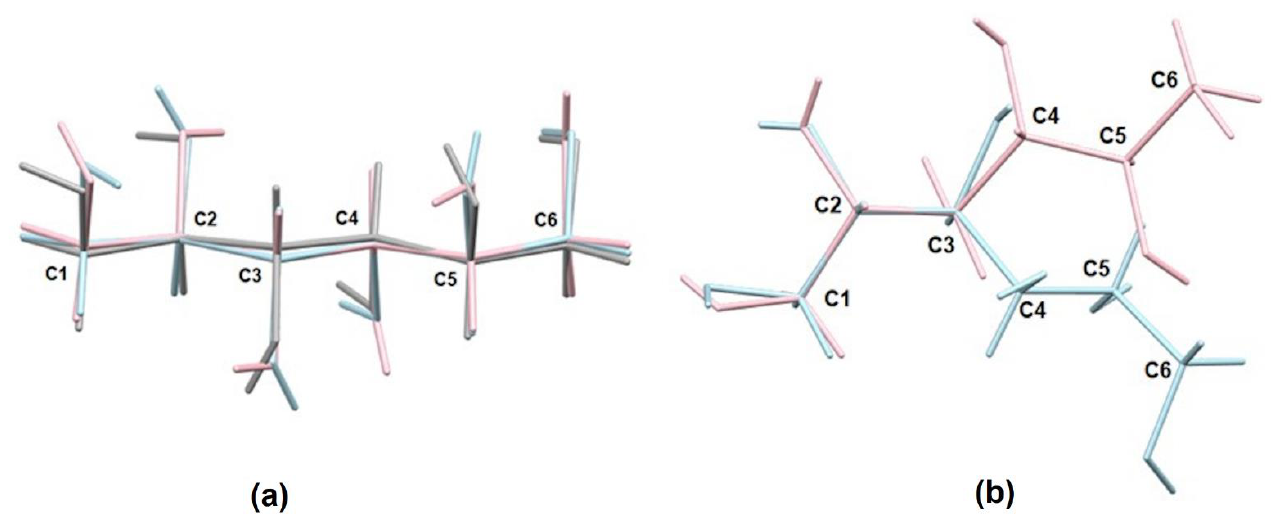
Figure 1. Overlay of rotamers of ( a ) D-mannitol— α (blue), β (pink), and δ (grey) [12]; and ( b ) sorbitol [13].